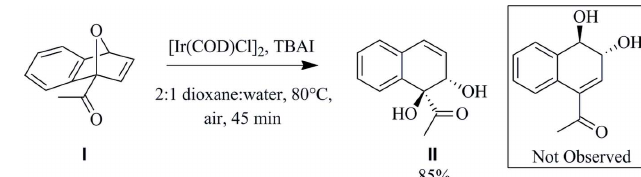
Figure 1 The reaction scheme.